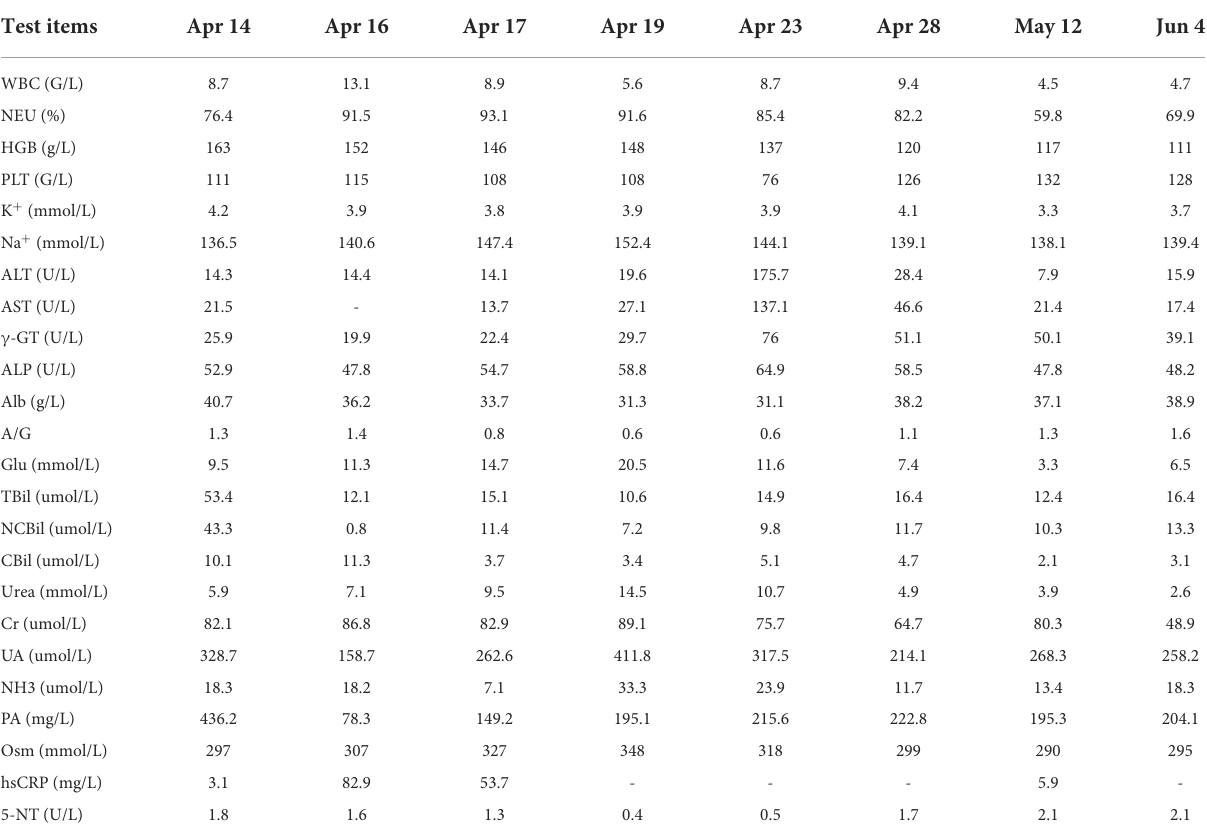
TABLE 1 Laboratory dynamic examination results of patients with pseudorabies virus